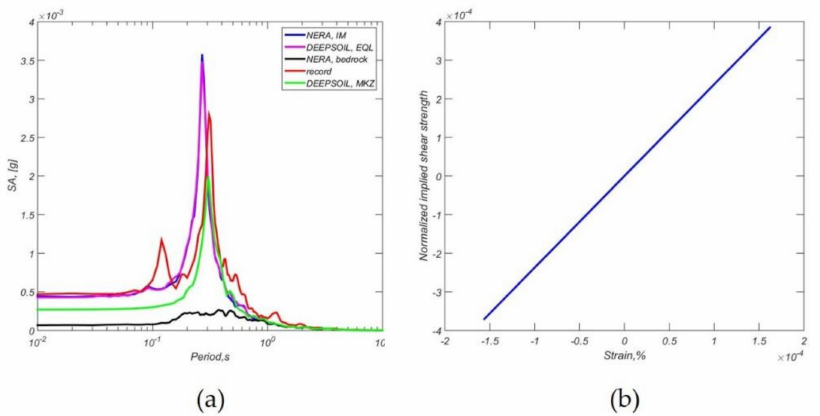
Figure 8. Modeling results for the Black Sea shelf site with soft clay layer of 5.5 m thickness: ( a ) response spectra SA(T, 5%) obtained by different modeling methods and real record; ( b ) stress–strain curves at the surface of the